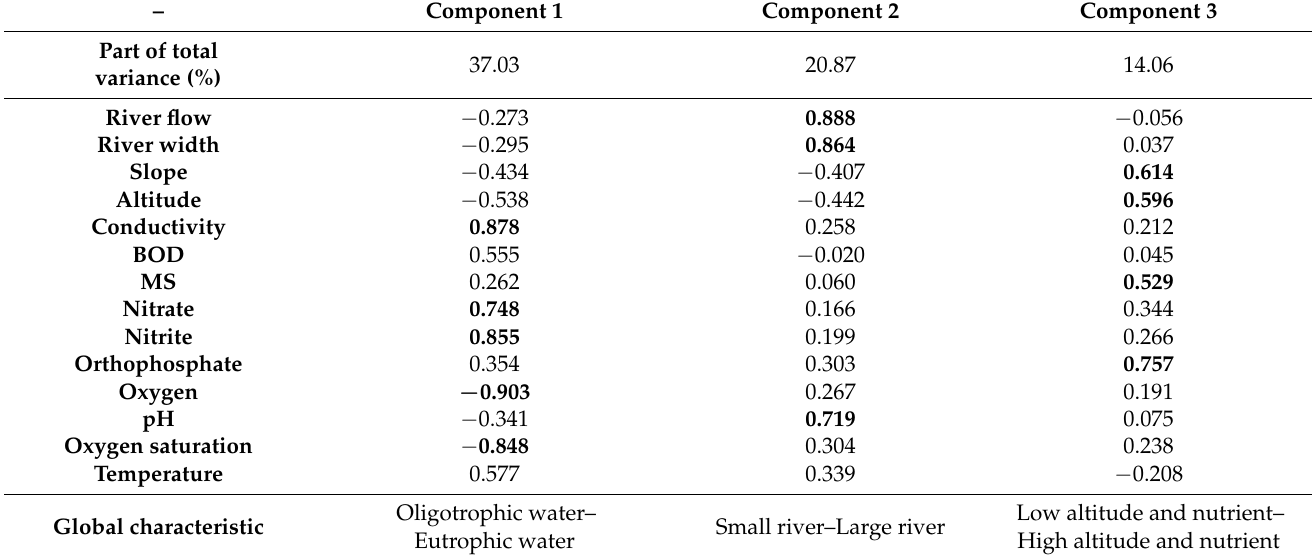
Table 1. Characteristics of the three first principal components from the principal component analysis (PCA) ran on the 14 environmental variables and used to characterize each of the 13 sampling sites. The part of the total environmental variance (%) and the contribution of each variable to each component are shown. The variables that contributed significantly to the axis are shown in bold. BOD = biological oxygen demand; SM = suspended